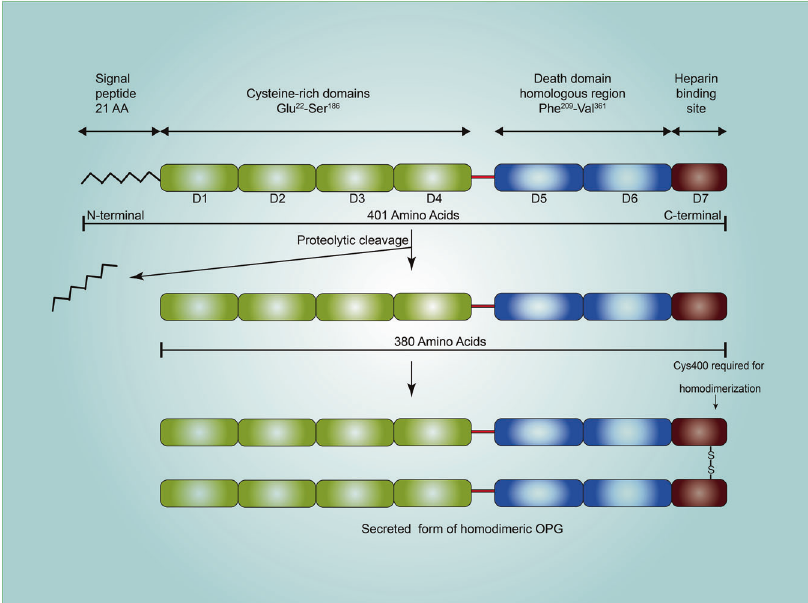
Fig. 1 Molecular structure and maturation process of secreted OPG. The signaling peptide is removed from full length OPG molecule before being secreted. The secreted OPG is a homodimer linked by disul fi de bonds. AA, amino acid, D (1 – 7) domain (1 – 7).